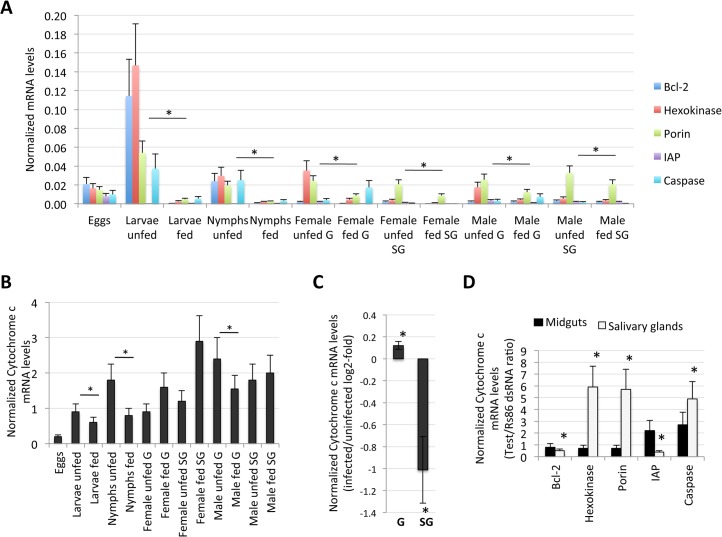
Expression of selected intrinsic apoptosis pathway genes.The analysis highlighted a complex mechanism by which tick cells respond to changes in the expression of intrinsic apoptosis pathway genes and suggested an effect of tick feeding on Porin expression that may also contributed to Porin down-regulation in infected adult female salivary glands. (A) Normalized Bcl-2, Hexokinase, Porin, IAP and Caspase mRNA levels (Ct values are shown as Ave+SD) in different tick developmental stages and tissues. (B) Normalized Cytochrome c mRNA levels are shown as Ave+SD in different tick developmental stages and tissues. The mRNA levels were characterized in tick eggs (three batches of approximately 500 eggs each), fed and unfed larvae (three pools of 50 larvae each), fed and unfed nymphs (three pools of 15 nymphs each), and fed and unfed males and females adults tick tissues (4 ticks each) by real-time RT-PCR normalizing against tick cyclophilin and ribosomal protein S4. Porin and Cytochrome c normalized Ct values were compared between fed and unfed ticks by Student's t-test with unequal variance (*P<0.05; N = 3–4). (C) Cytochrome c mRNA levels were determined in infected and uninfected female midguts (G) and salivary glands (SG), normalized against tick tick cyclophilin and ribosomal protein S4, represented as infected/uninfected Log2-fold ratio (Ave+SD) and normalized Ct values compared between infected and uninfected ticks by Student's t-test with unequal variance (*P<0.05; N = 10). (D) Cytochrome c mRNA levels were determined in midguts and salivary glands of ticks with gene knockdown, normalized against tick tick cyclophilin and ribosomal protein S4, represented as test/dsRNA ratio (Ave+SD) and normalized Ct values compared between ticks injected with test genes dsRNA and Rs86 control dsRNA by Student's t-test with unequal variance (*P<0.05). Abbreviation: IAP, apoptosis inhibitor.